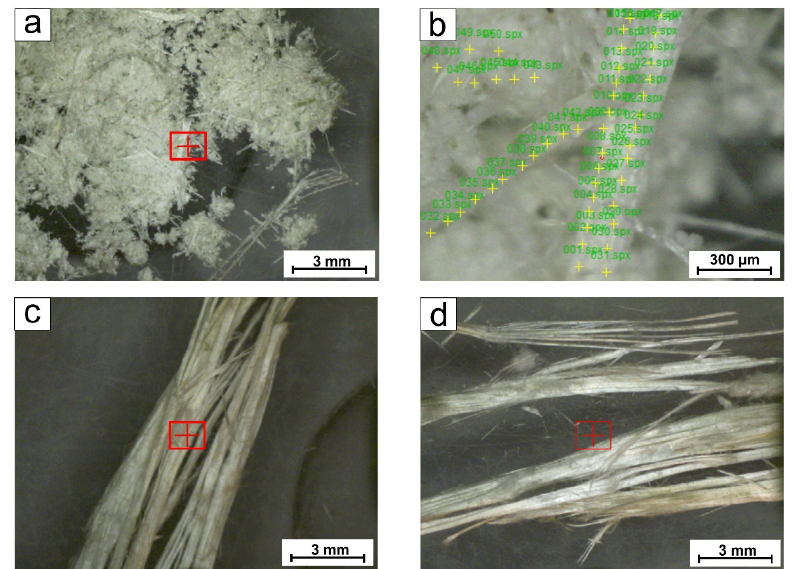
Figure 1. Micro X-ray fluorescence ( µ -XRF) images of: ( a , b ) tremolite asbestos from Episcopia village (TR_EPS specimen), crosses are drawn to indicate the analysis points; ( c , d ) tremolite asbestos from San Severino Lucano village (TR_SSL specimen).